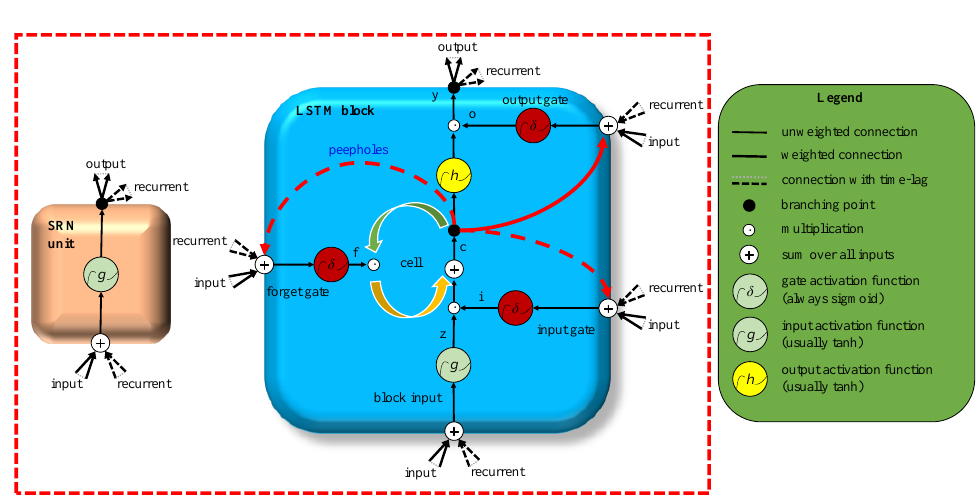
Figure 1. Ground-truth RNN.